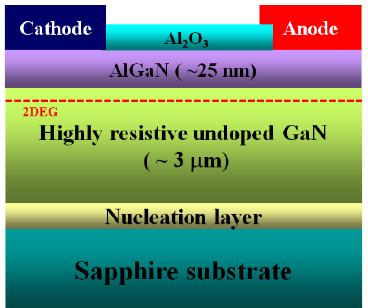
Figure 1. A schematic view of the proposed Schottky barrier diodes ( SBD), including epitaxial layers and